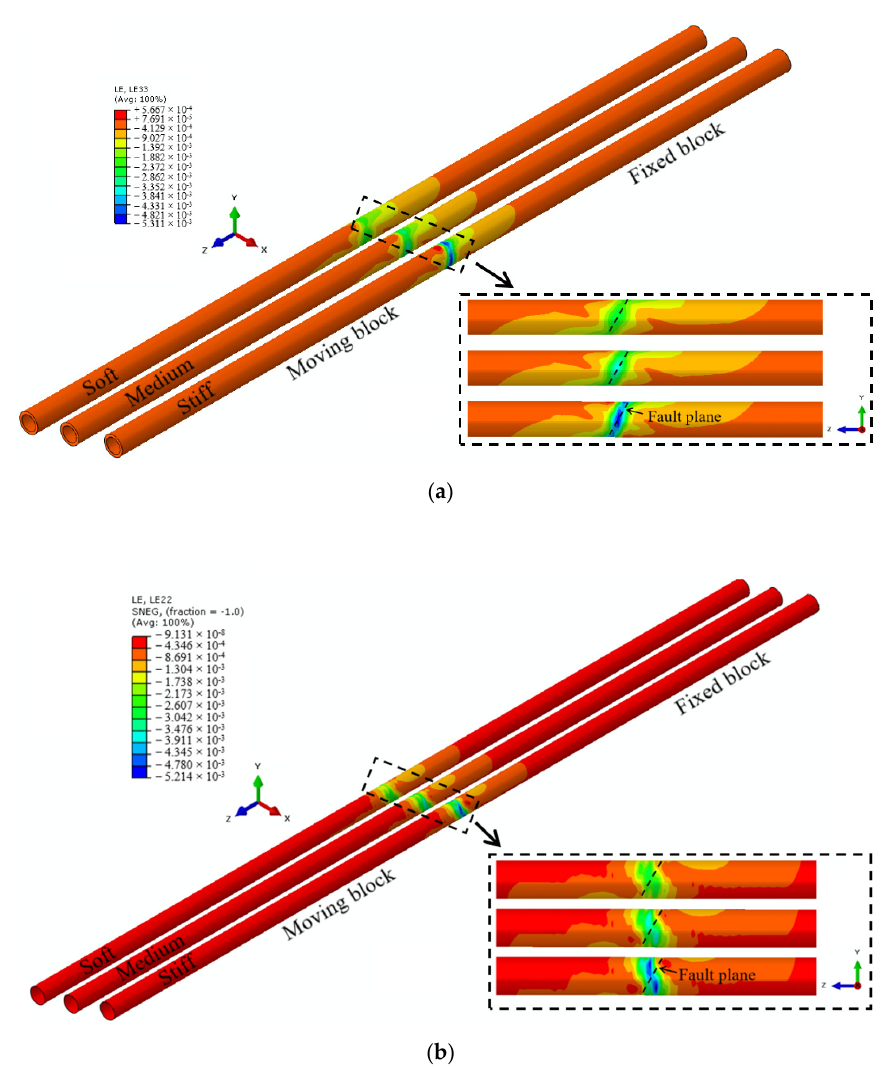
Figure 13. Axial strain nephogram of composite lining structures with different fault properties in the fault fracture zone ( Δ f = 8 cm and β = 60°): ( a ) Concrete lining and ( b ) steel tube lining.